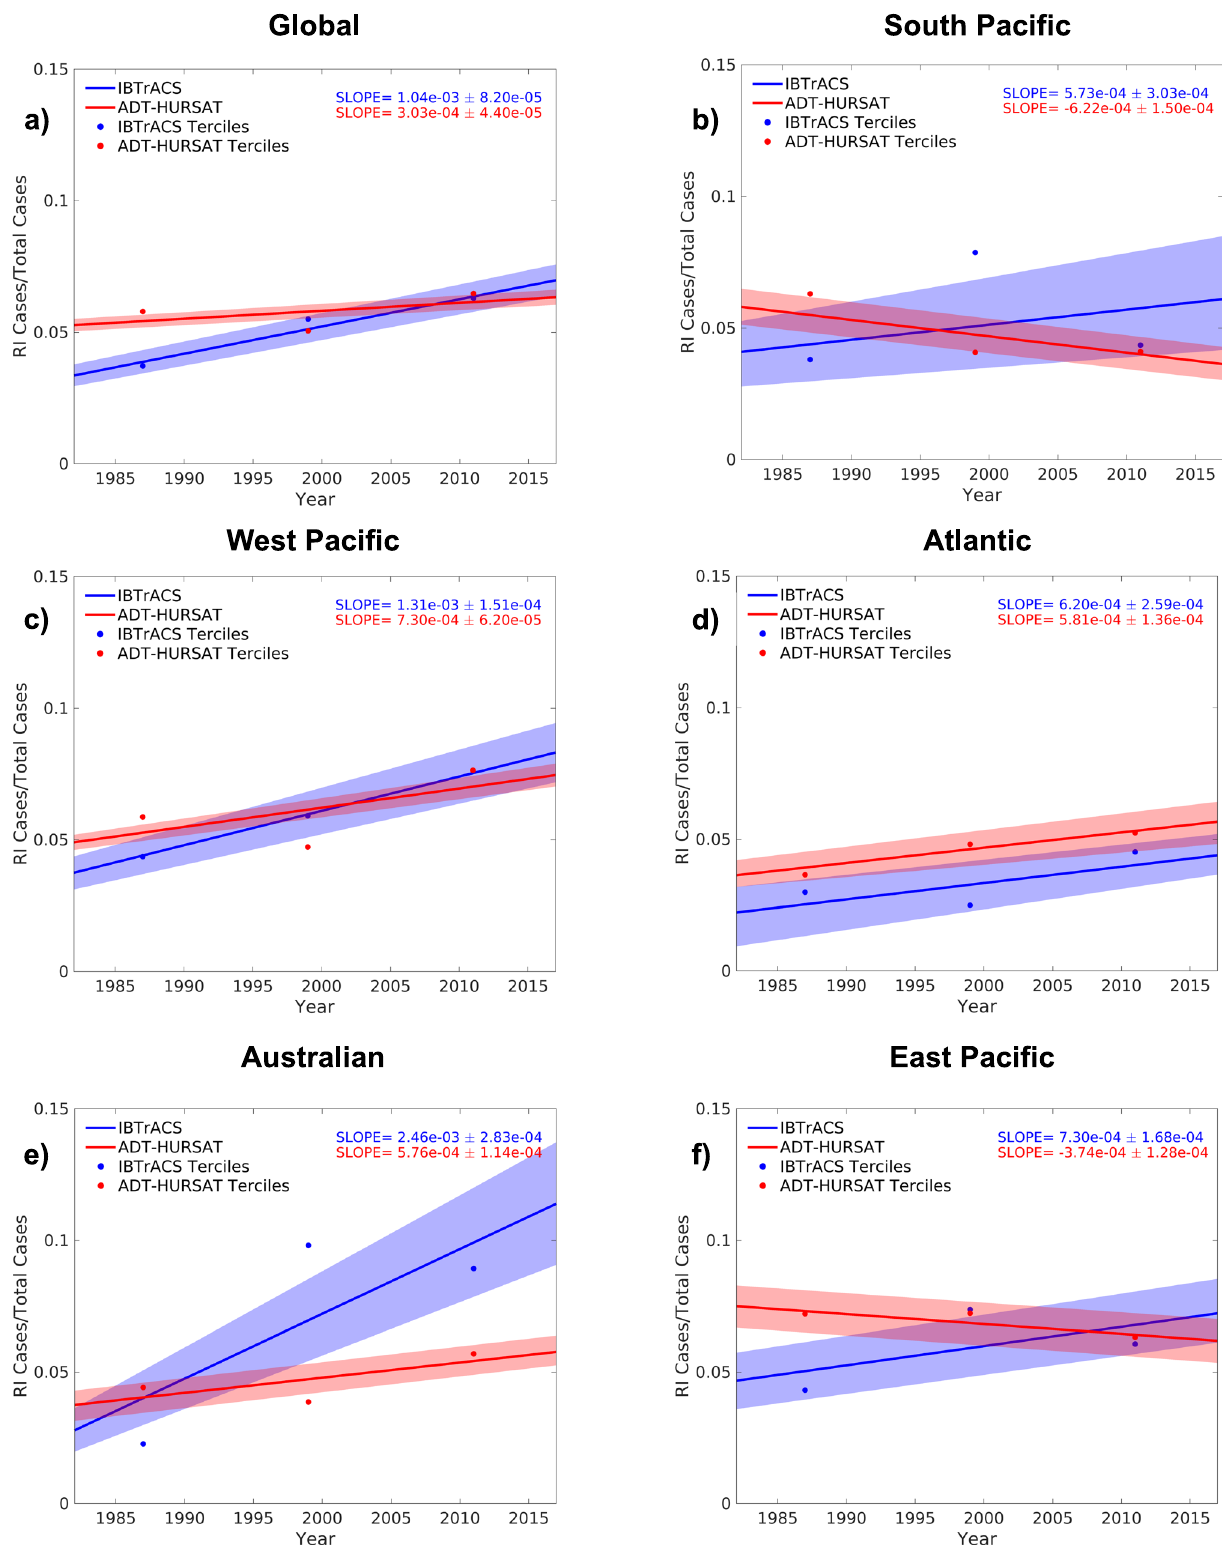
Fig. 1 | Rapid intensi fi cation ratio trends. Observed trends in the rapid intensi- fi cation(RI)ratioofADT-HURSAT(blue)andIBTrACS(red)overthe36-yearperiod 1982 – 2017 using ( a ) Global and ( b ) South Paci fi c ( c ) West Paci fi c ( d ) Atlantic ( e ) Australian( f )andEastPaci fi cdata.RIratioisde fi nedasthenumberof24-hintensity changesabove30knotsdividedbythetotalnumberof24-hintensitychanges.The 36-year period is divided into three terciles (1982 – 1993, 1994 – 2005, 2006 – 2017)